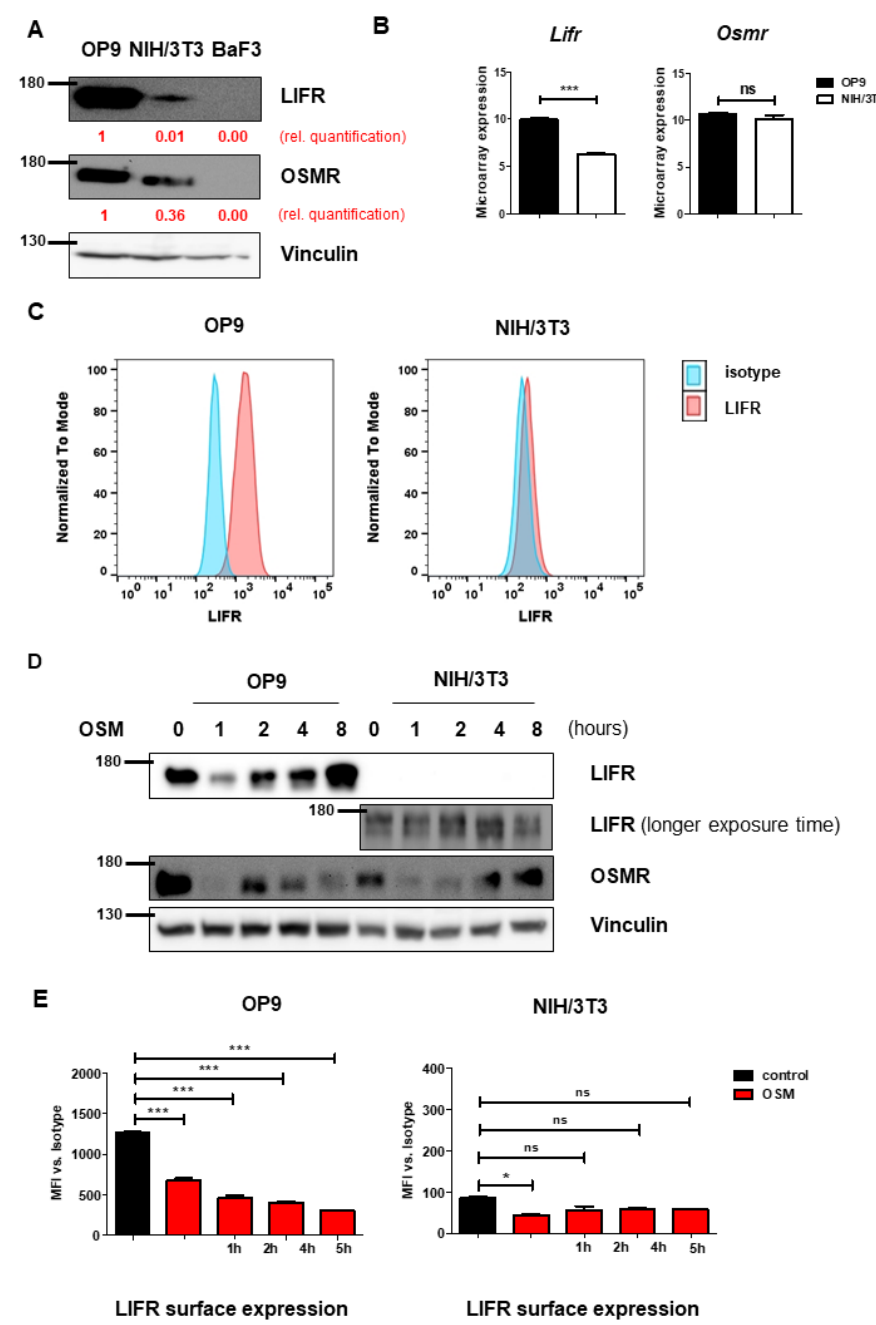
Figure 2. OP9 and NIH/3T3 cells show differential levels of OSMR and LIFR. ( A ) OP9 and NIH/3T3 cells were examined for LIFR and OSMR expression. BaF3 cells were used as a negative control. Protein molecular weight is labeled in kDa. Relative protein quantities are marked in red. ( B ) Microarray analysis of OP9 and NIH/3T3 cells showing Osmr and Lifr expression. The p -values were calculated by Transcriptome Analysis Console software. *** p < 0.001. ns = not significant. ( C ) OP9 and NIH/3T3 cells were analyzed for LIFR surface expression using FACS. ( D ) OP9 and NIH/3T3 cells were examined for expression of LIFR and OSMR in relation to different incubation periods with 10 ng/mL mOSM. Protein molecular weight is labeled in kDa. ( E ) OP9 and NIH/3T3 cells were examined for LIFR surface expression in relation to different incubation periods with 10 ng/mL mOSM. p -Values were calculated using one-way ANOVA and Bonferroni post-test. * p <0.05 and *** p < 0.001. ns = not